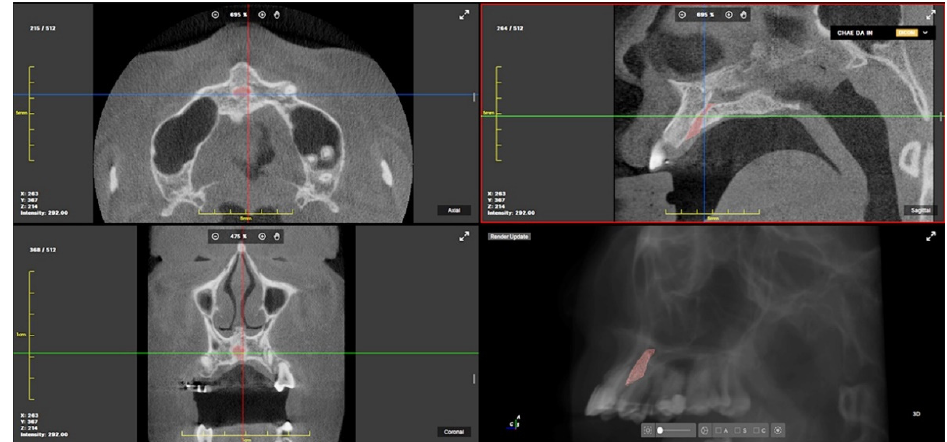
Figure 4. Axial, sagittal, coronal view and the result of volume rendering of the IC on pretreatment CBCT (red).